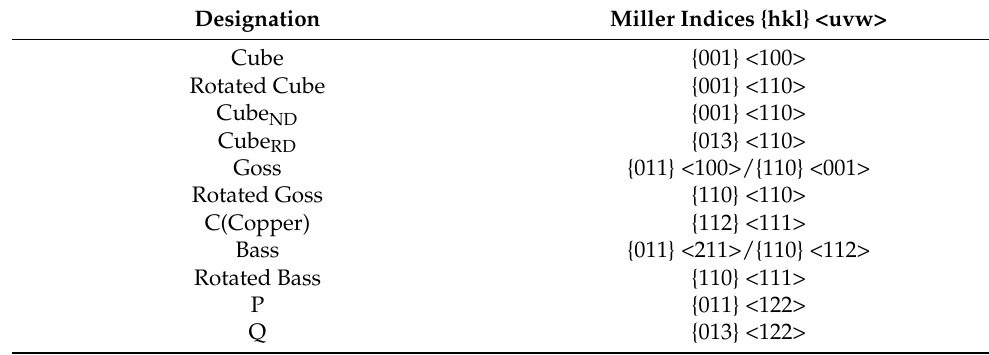
Figure 11. ( a1 – c1 ) show the distribution of several typical recrystallization structures at 700 ◦ C/1 s − 1 , 800 ◦ C/0.001 s − 1 , and 900 ◦ C/0.001 s − 1 , respectively; ( a2 – c2 ) show the local average misorientation (LAM) in the central region at 700 ◦ C/1 s − 1 , 800 ◦ C/0.001 s − 1 , and 900 ◦ C/0.001 s − 1 , respec- tively; ( a3 – c3 ) are histograms of the distribution of LAM at 700 ◦ C/1 s − 1 , 800 ◦ C/0.001 s − 1 , and 900 ◦ C/0.001 s − 1 , respectively. Table 3. Several typical FCC metal recrystallization textures [40].